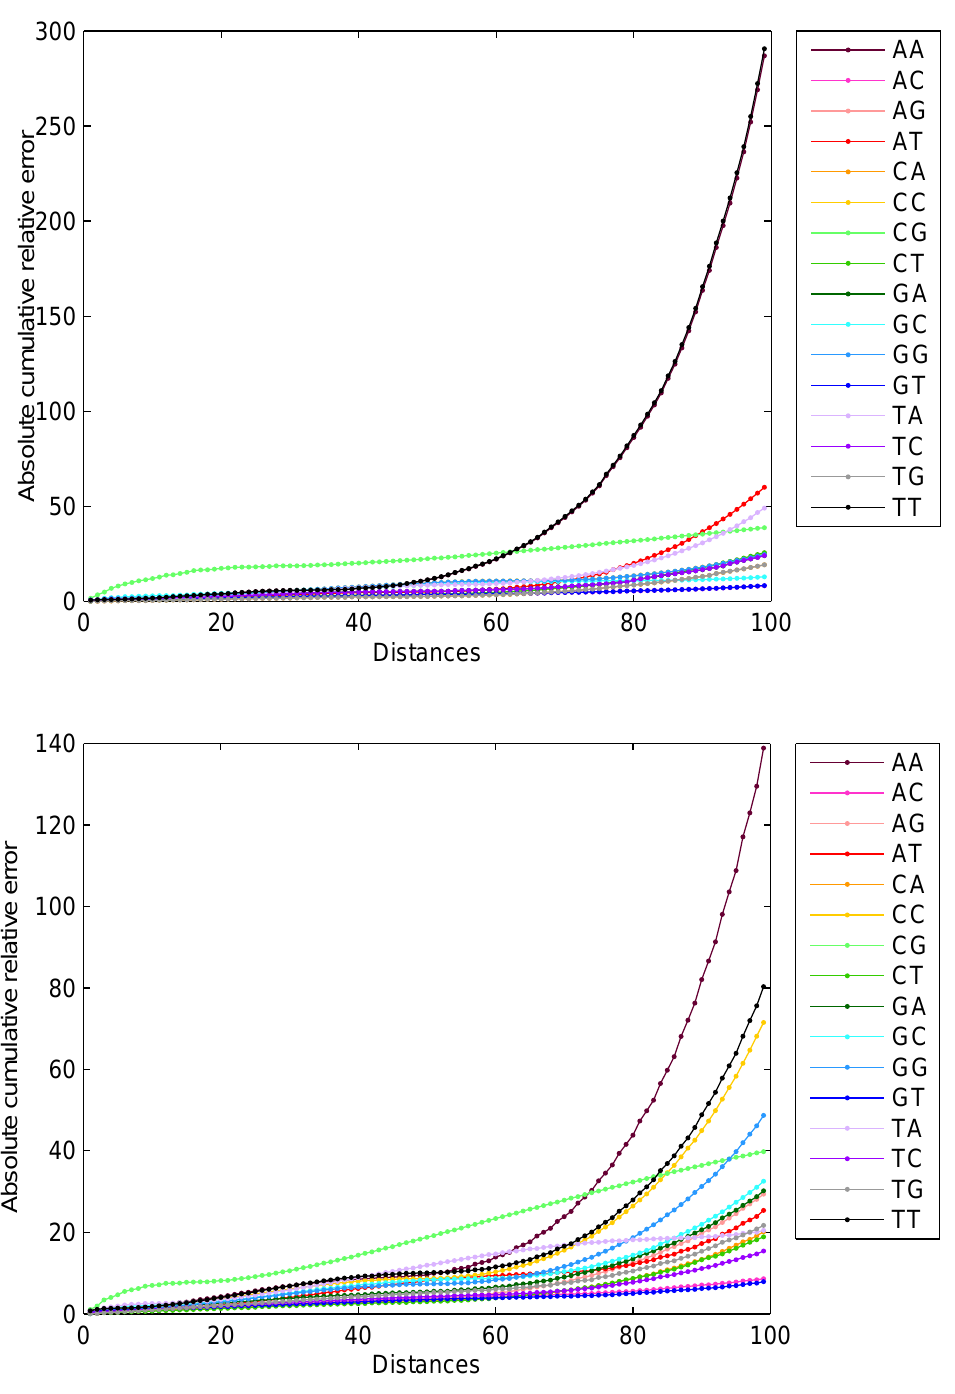
Figure 3: Absolute cumulative relative error, S r ( i ) , for the first 100 distances of each dinucleotide in the whole-genome (top) and protein-coding (bottom) distributions. Note the singular behavior of the AA, TT and CG dinucleotide